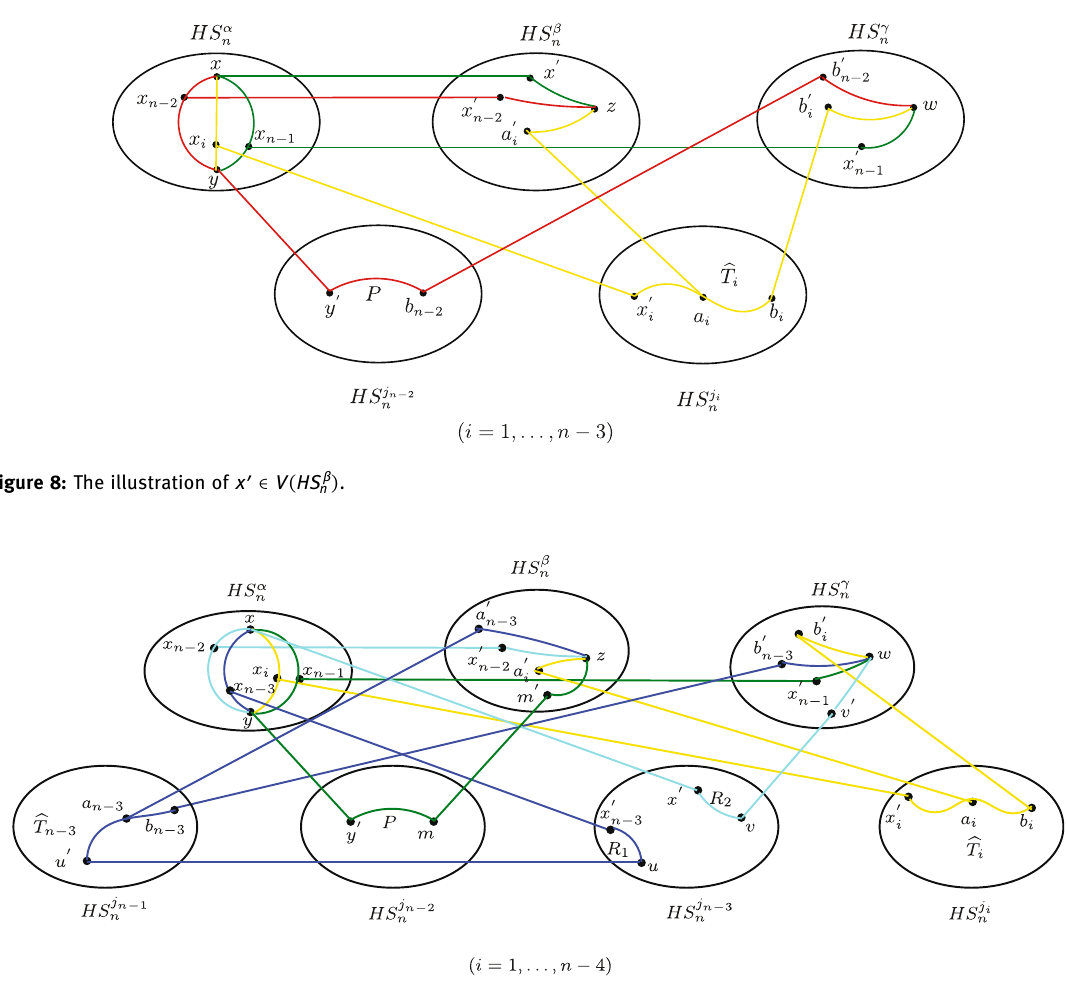
Figure 9: The illustration of Case